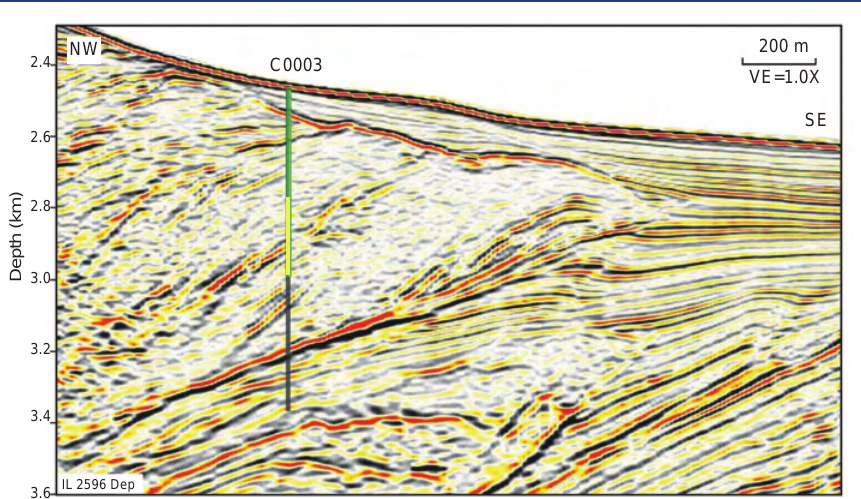
Figure 7. Site C0003 on Inline 2596. Black line is the originally planned total depth of 1000 mbsf; green line is actual depth achieved when the drill string became stuck. Yellow line is approximate length of stuck and abandoned bottom-hole assembly . The reflector that intersects the borehole at ~2.9 km depth is interpreted as a fault zone, and is the probable source of dated cavings in the